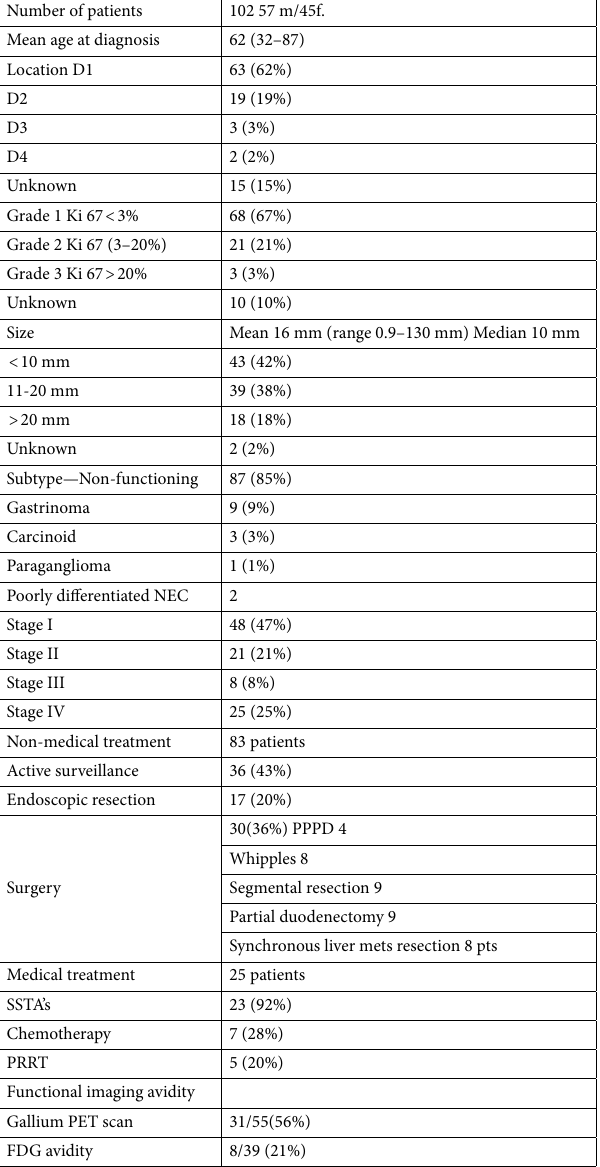
Table 1. Demographics and clinical characteristics of 102 dNENs. PPPD –pylorus preserving pancreatoduodenectomy. SSTA – somatostatin analogues. PRRT – peptide radiolabelled receptor targeted